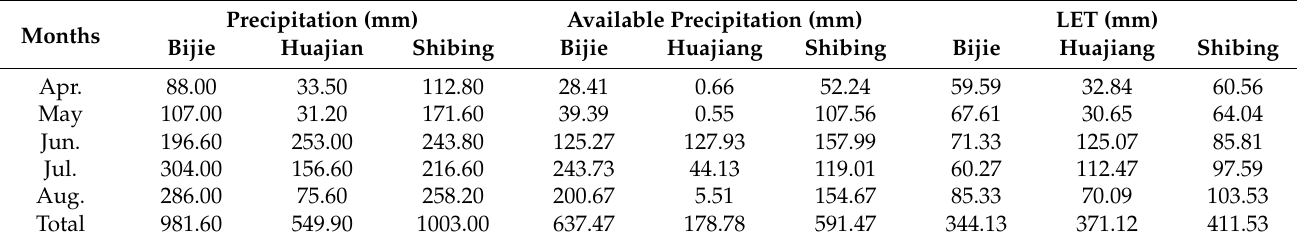
Table 2. Precipitation, available precipitation and LET distribution in study